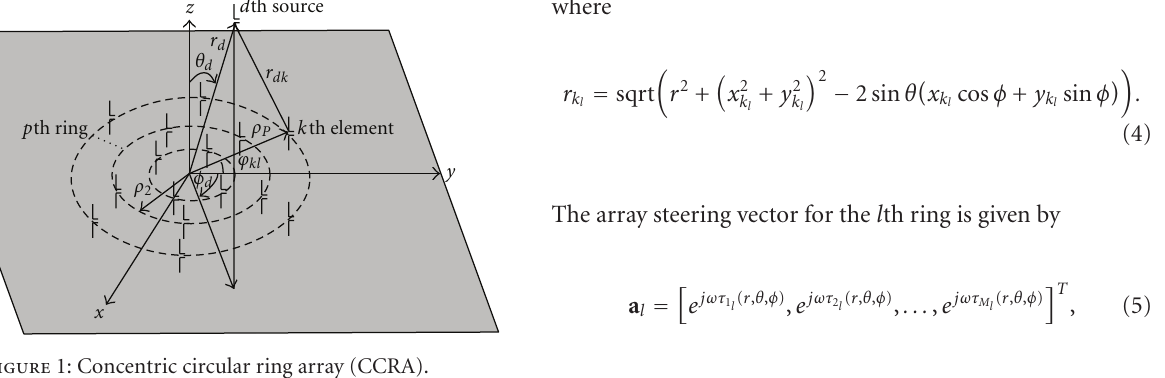
Figure 1: Concentric circular ring array